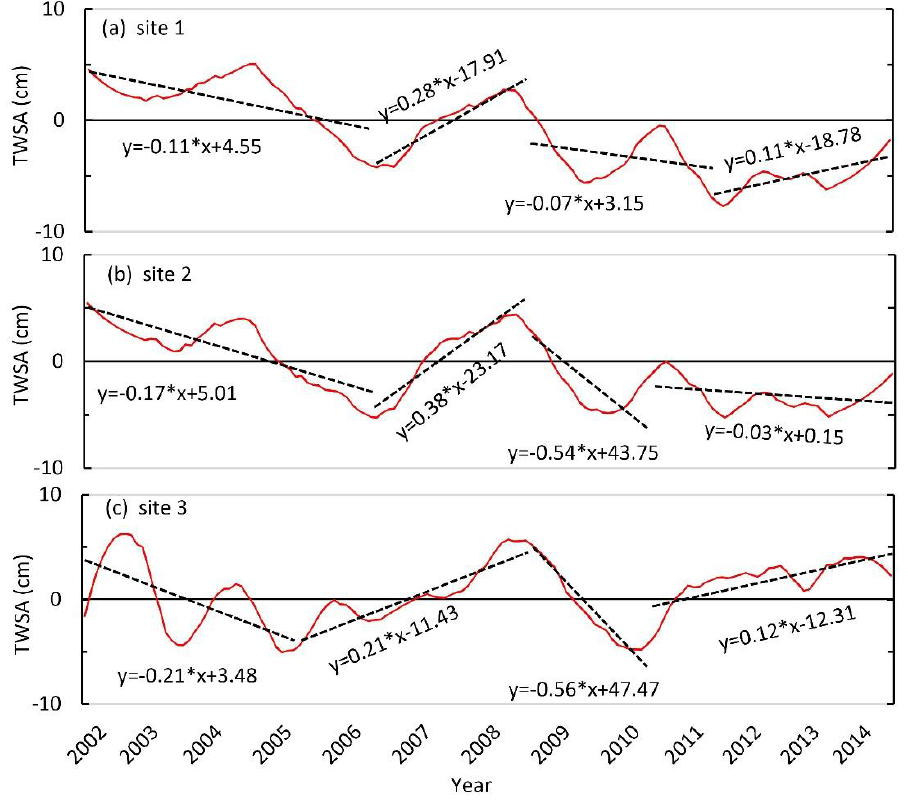
Figure 3. Variations of de-seasonalized Total Water Storage Anomalies in the three grids located in north (site 1), northwest (site 2) and south (site 3) parts of Yunnan Province. The red solid lines are de-seasonalized Total Water Storage Anomalies. The black dashed lines represent the linear trends of de-seasonalized TWSA during four segments. The x in the fitting equation represents the sequential coding of corresponding months from 0 to 139.